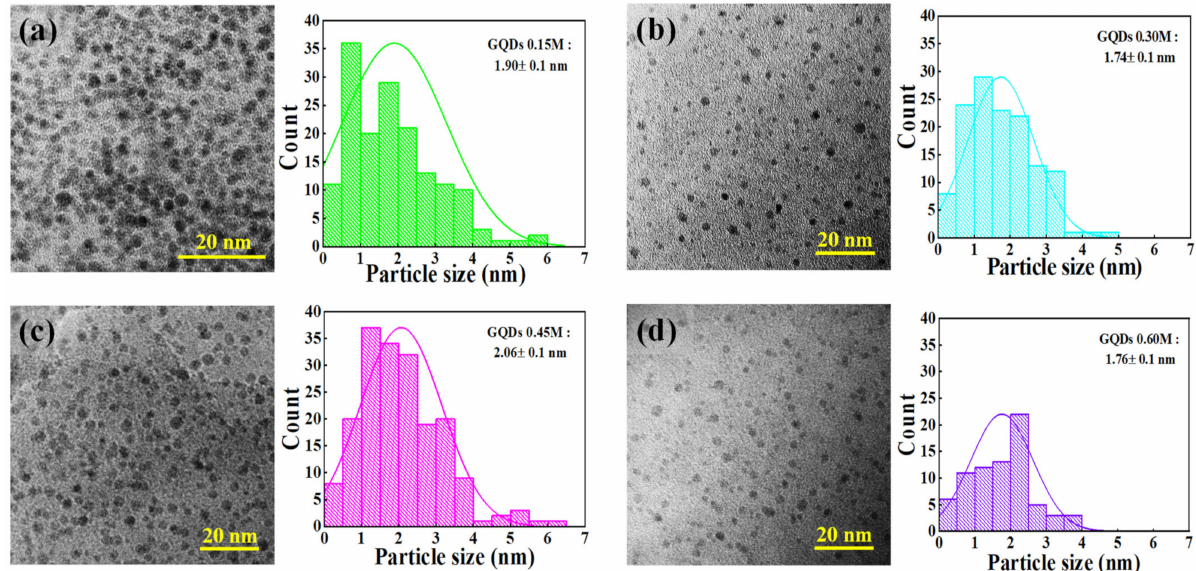
Figure 2. TEM images of GQDs with the particle size distribution for electrolyte concentrations of ( a ) 0.15M, ( b ) 0.30M, ( c ) 0.45M, and ( d ) 0.60M,